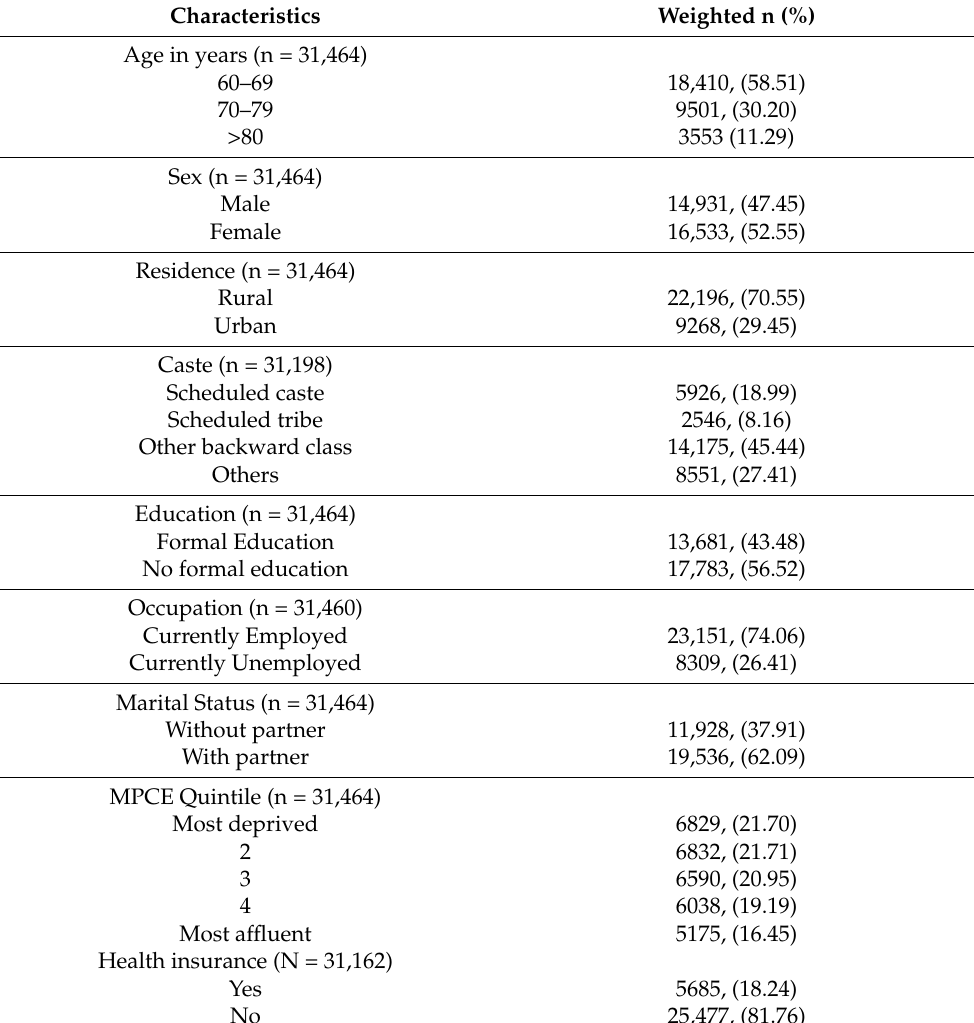
Table 1. Characteristics of the study population.